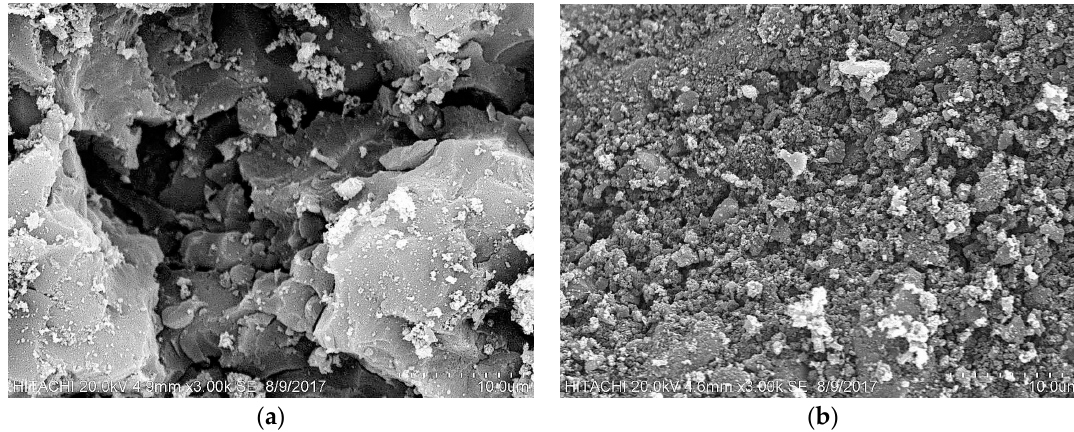
Figure 1. SEM photograph at 3000 × magnification of: ( a ) non-pretreated; ( b ) microwave pretreated CSAC